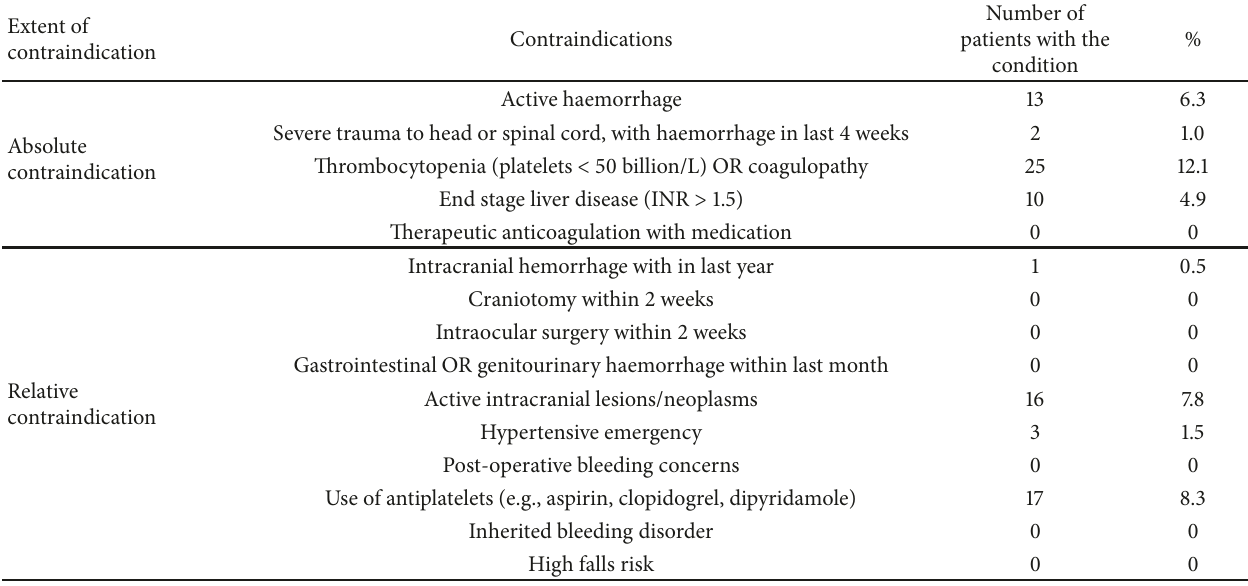
Table 3: Contraindications for thromboprophylaxis among study subjects.